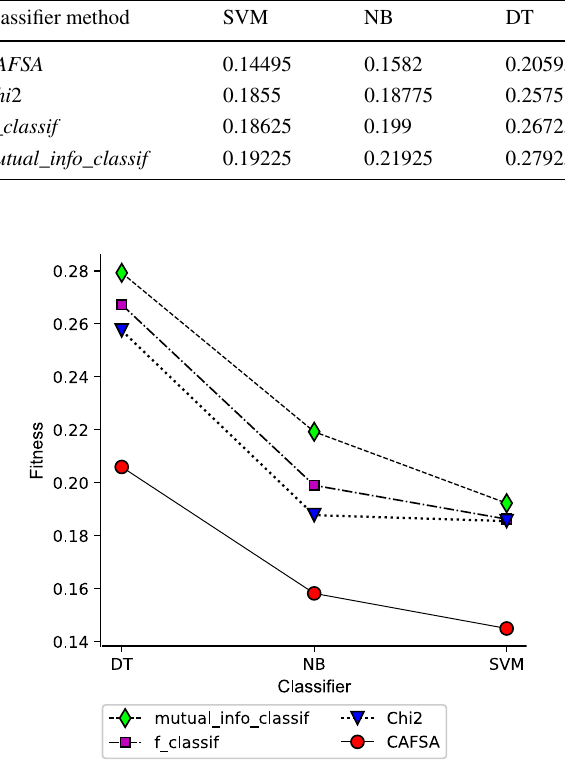
Fig. 14 Chi-square test and CAFSA performance on ChnSenticorp_ Hotel data